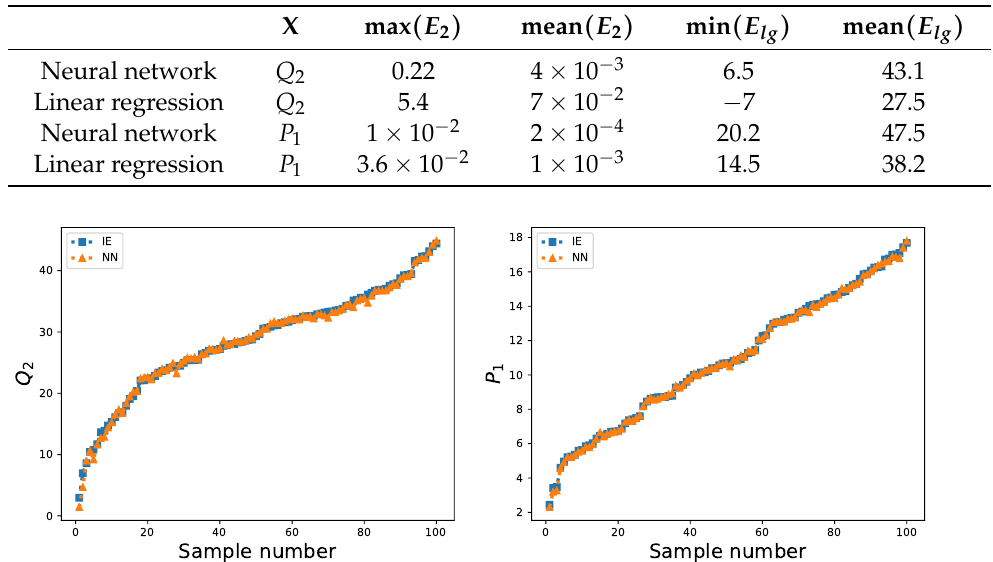
Table 3. Mean and maximum values of the relative error functional (9) for the neural network and linear regression models.